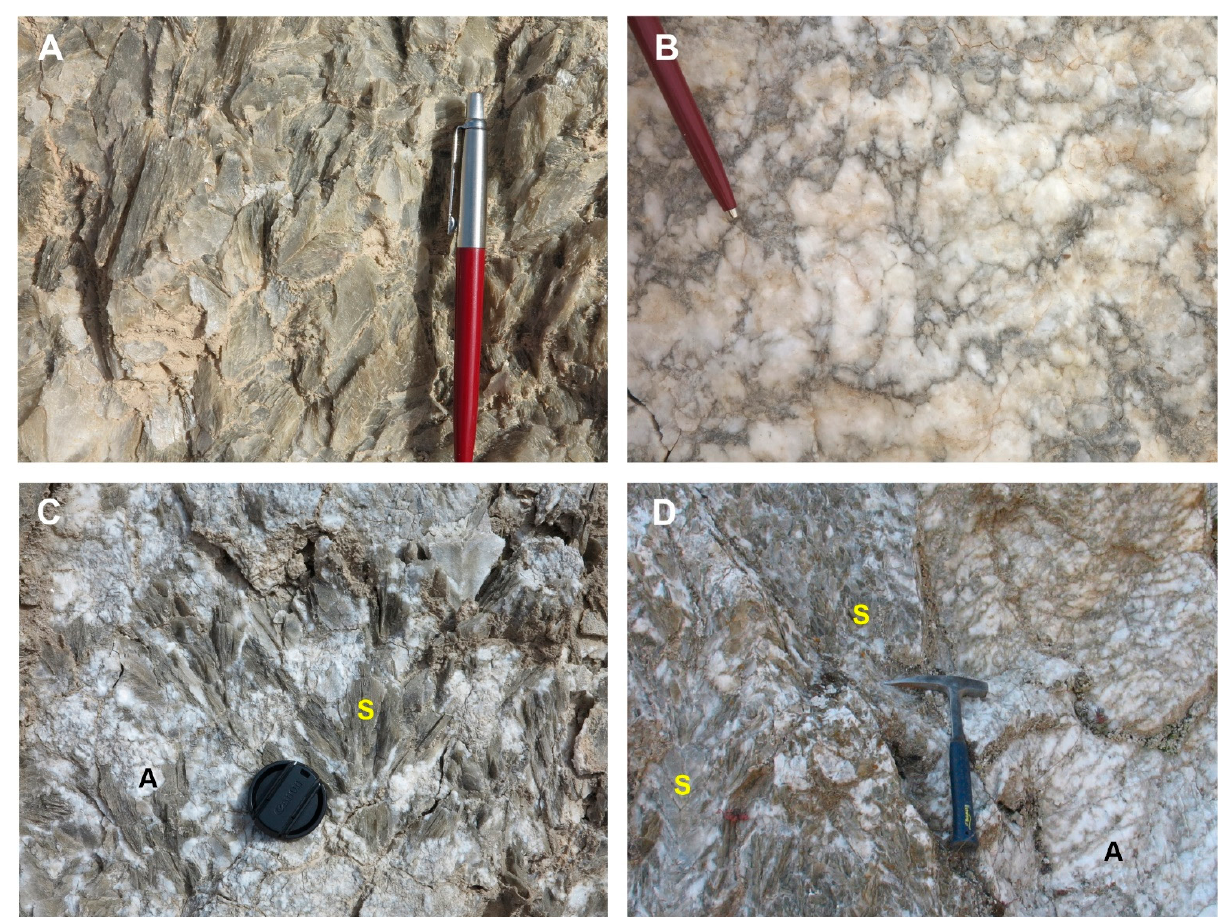
Figure 7. Different lithofacies of the outcropping gypsum: ( A ) selenite gypsum (macrocrystalline); ( B ) white nodular alabastrine gypsum (microcrystalline); ( C ) white alabastrine gypsum around the large selenite crystals; ( D ) lateral transition zone from selenitic to alabastrine gypsum (white). Legend: S, selenite gypsum; A, alabastrine gypsum.